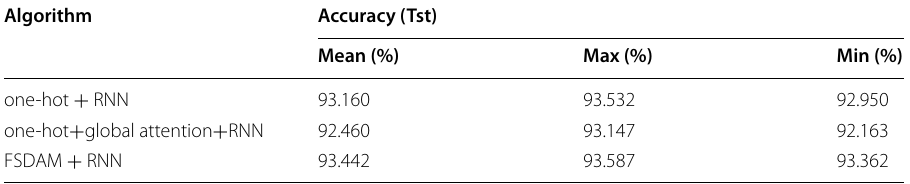
Table 15 Accuracy of different methods on AWID